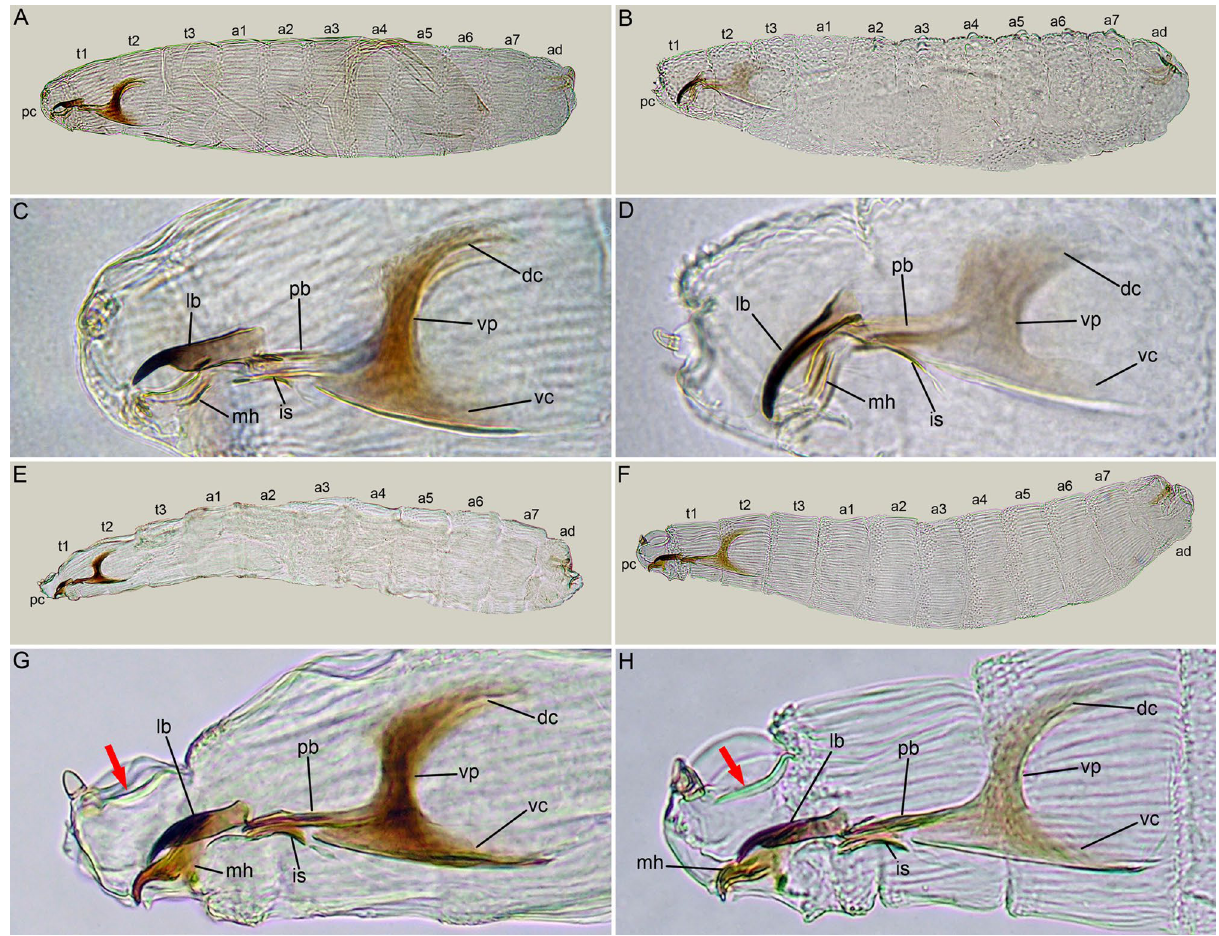
auriceps ., cephaloskeleton, lateral view. ( E ) Protomiltogramma cincta , habitus, lateral view. ( F ) Protomiltogramma plebeia , habitus, lateral view. ( G ) Protomiltogramma cincta , cephaloskeleton, lateral view. ( H ) Protomiltogramma cincta , cephaloskeleton, lateral view. Scale bar 0.1 mm. a1–7, abdominal segments; ad, anal division; dc, dorsal cornua; is, intermediate sclerite; lb, labrum; mh, mouthhook; pb, parastomal bar; pc, pseudocephalon; t1–3, thoracic segments; vc, ventral cornua; vp, vertical